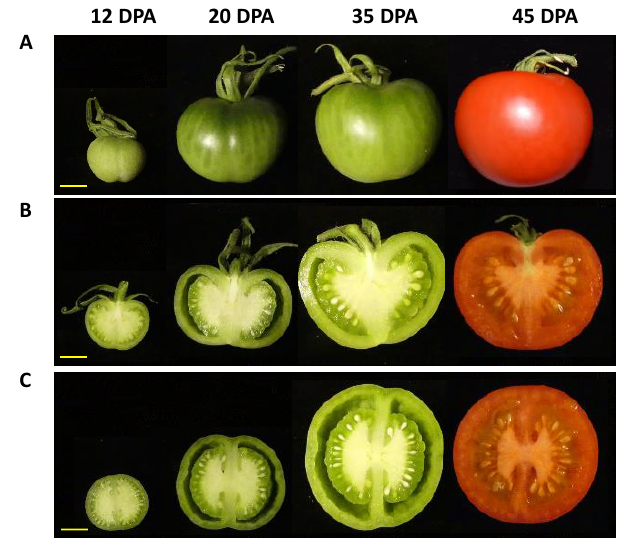
Figure 2. Fruit development of Ailsa Craig tomato from 12 to 45 DPA. ( A ) Whole fruit. ( B ) Fruit longitudinal section. ( C ) Fruit equatorial section. Bars = 1 cm.